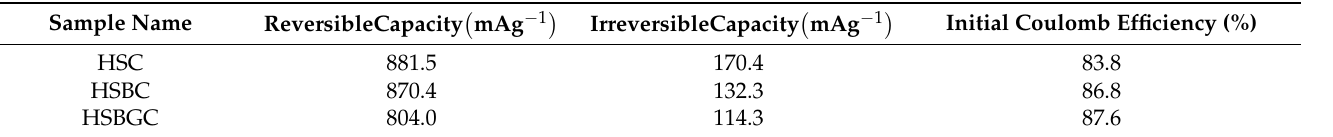
Figure 6. Charge–Discharge curves of ( a ) HSC, ( b ) HSBC and ( c ) HSBGC samples for first two cycles. Table 1. The reversible capacity, the irreversible capacity and the initial coulombic efficiency of HSC, HSBC and HSBGC